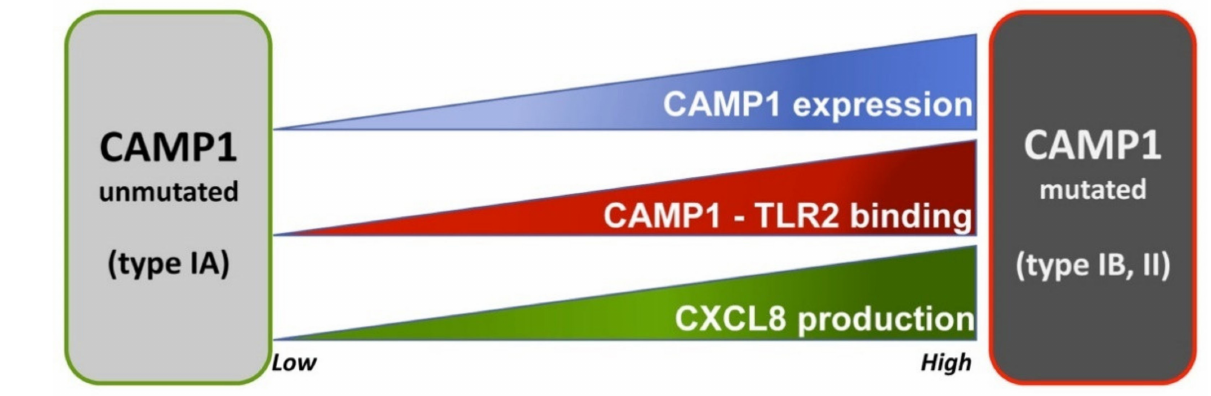
Figure 4. Relationship between CAMP factor 1 polymorphism and